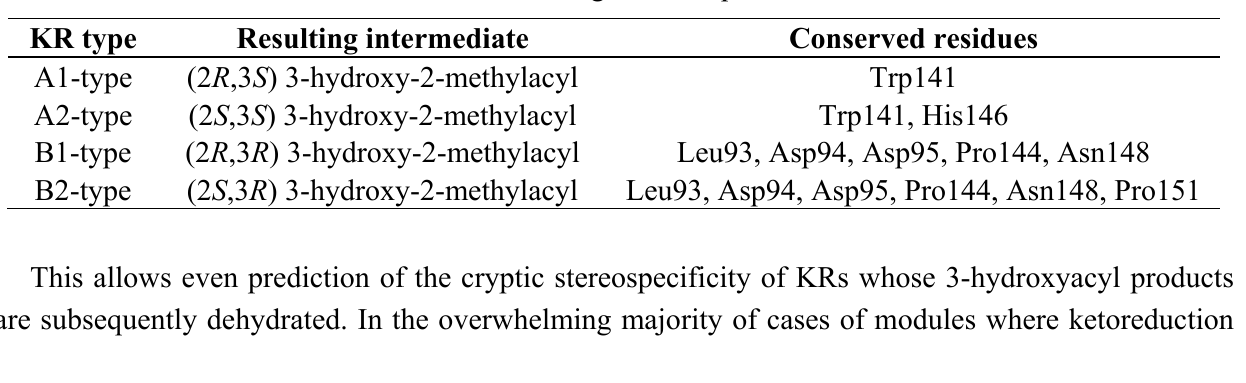
Table 1. KR signature